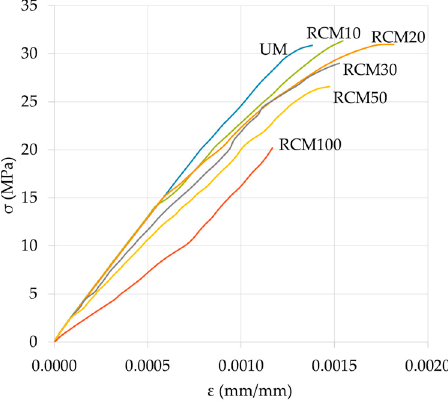
Figure 9. σ - ε curves of the RCM.